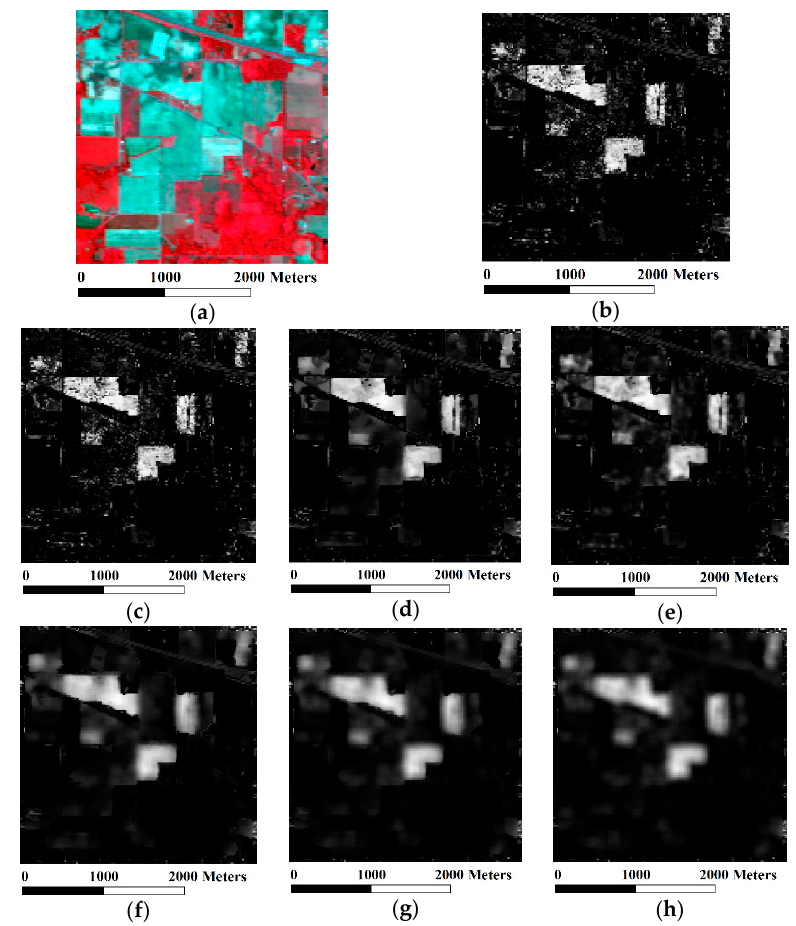
Figure 13. Smoothed probability maps for the Indian Pines image in terms of the class of Corn-no till using different values of σ r : ( a ) three-band color composite image (bands 47, 23 and 13); and ( b ) the original SVM probability map. The smoothed probability maps obtained using: ( c ) σ r = 0.001; ( d ) σ r = 0.005; ( e ) σ r = 0.01; ( f ) σ r = 0.02; ( g ) σ r = 0.04; and ( h ) σ r =